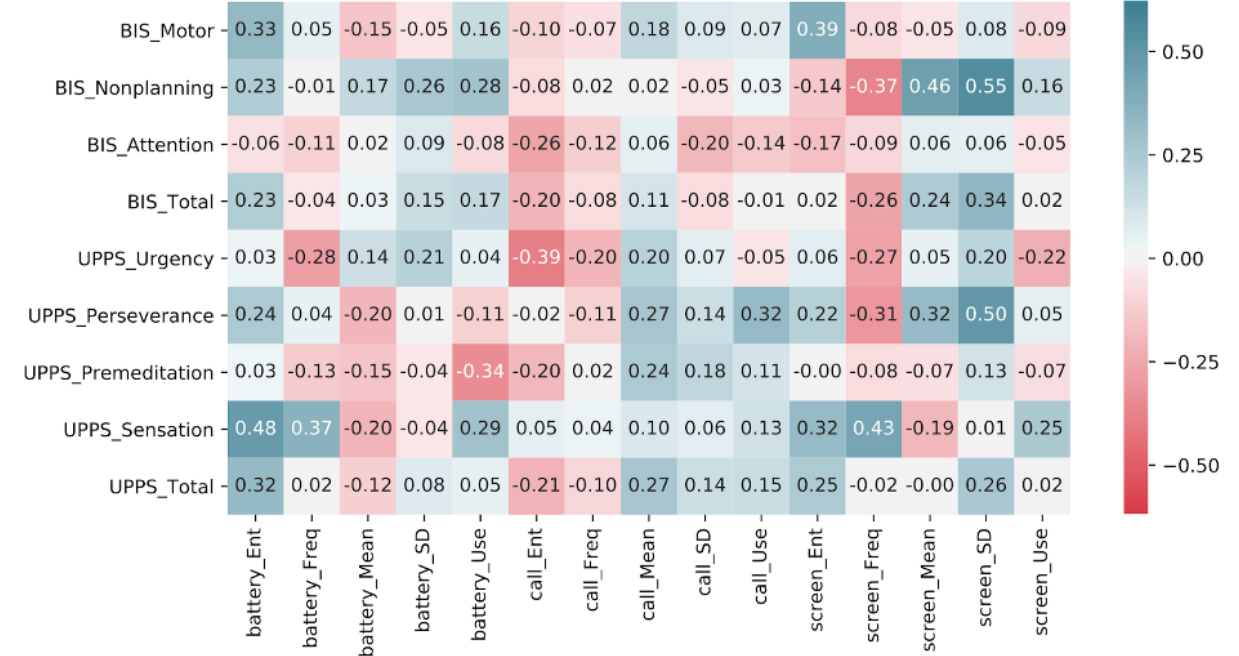
Figure 2. Correlation between the 15 features of mobile sensor data and trait impulsivity scales (15-item short form of the Barratt Impulsiveness Scale [BIS-15] and UPPS) and subscales. Ent: entropy; Freq: frequency per hour; Mean: use mean; SD: use deviations; Use: use duration per